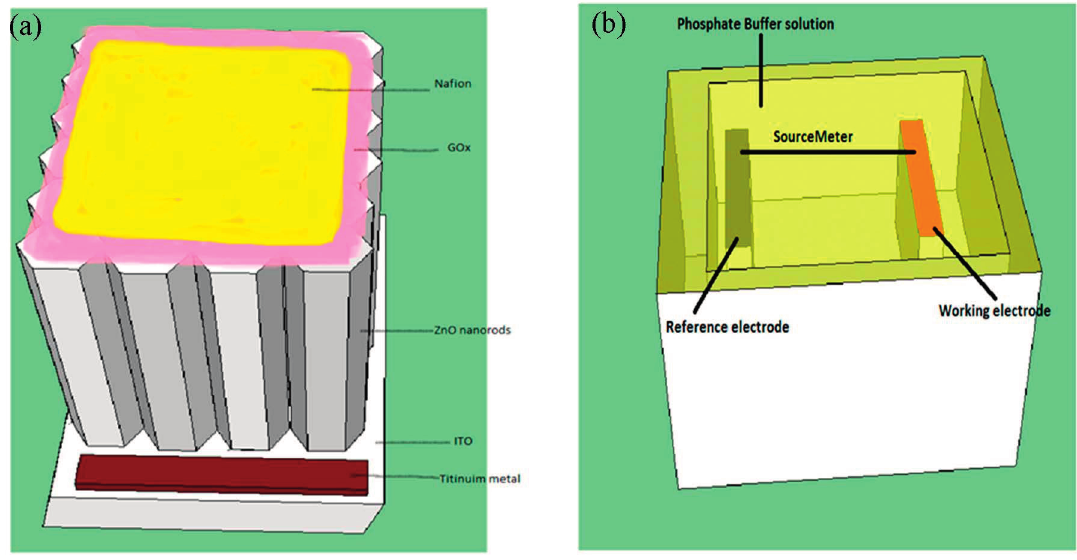
Figure 1. The structure of the working electrode ( a ), and the schematic structure of the electrochemical experimental setup ( b